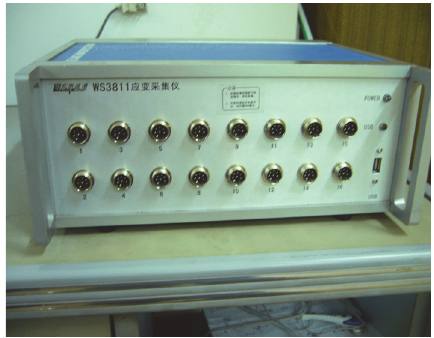
Figure 6: The dynamic strain sensor WS3811 developed by the Beij- ing Wavespectrum.